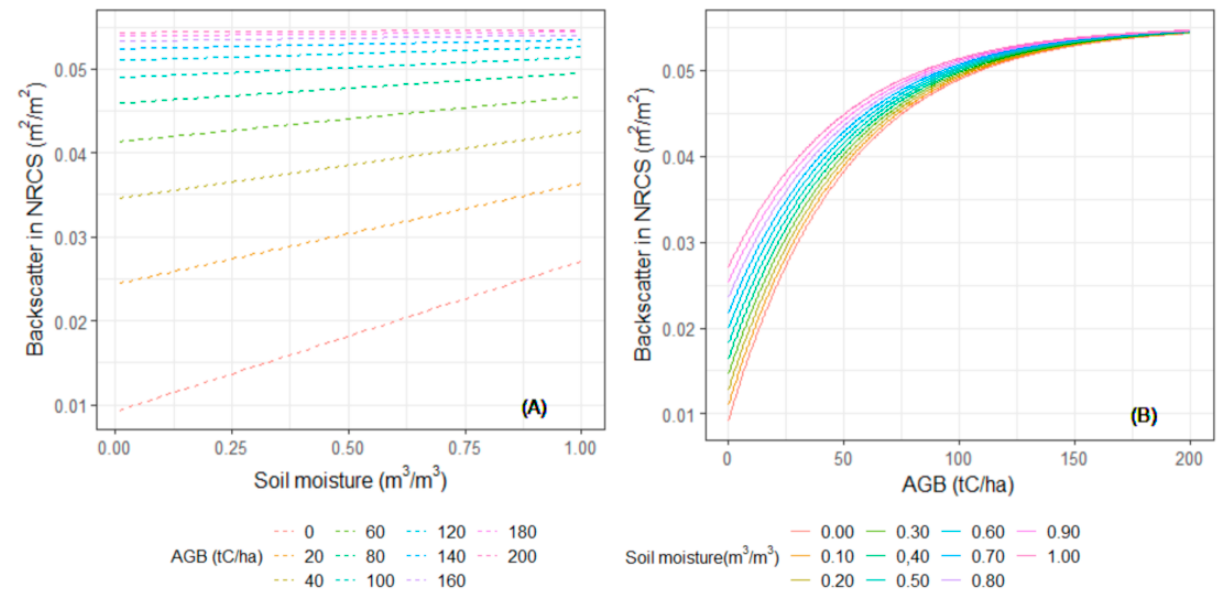
Figure 6. Predicted backscatter (m 2 /m 2 ) from the fitted WCM std model versus different levels of AGBC ( A ) and surface soil moisture ( B ). Plot ( A ) shows the backscatter prediction from different AGBC levels when soil moisture increased from 0.00 to 1.00 m 3 /m 3 . Each line is a 20 tC/ha increase in AGBC from 0 to 200 tC/ha; Plot ( B ) shows thee backscatter prediction from different soil moisture levels when AGBC increased from 0 to 200 tC/ha. Each line is a 0.1 m 3 /m 3 increase in soil moisture from 0.00 to 1.00 m 3 /m 3 .